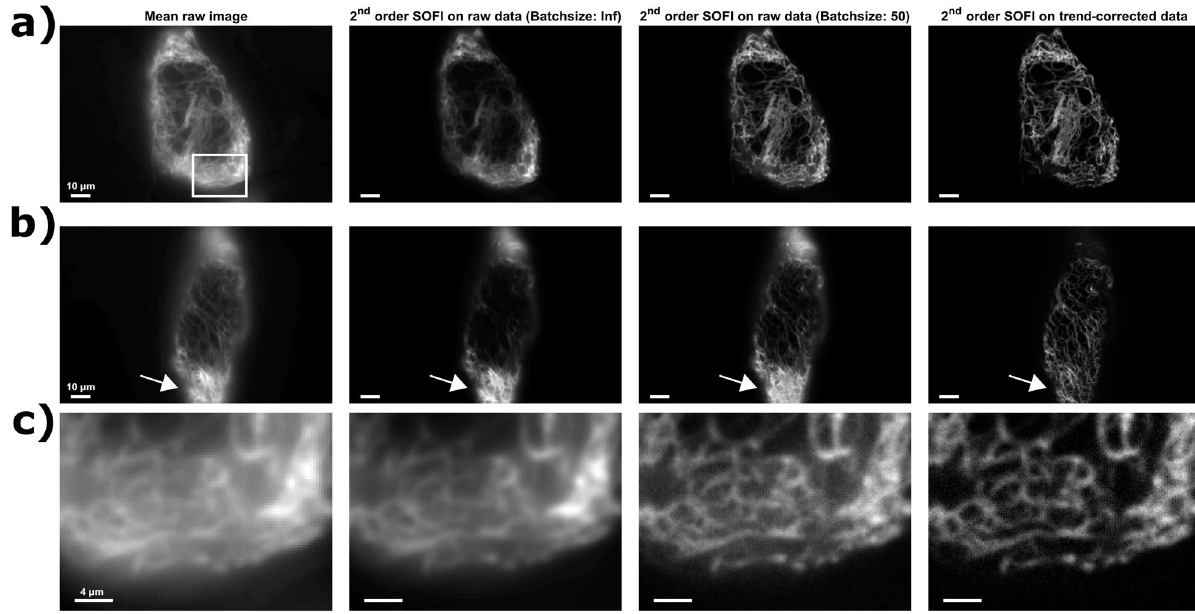
Figure 2. Second order SOFI results on two different datasets as shown in ( a ) and ( b ). The mean raw image is compared to the second order SOFI result on the entire raw data sequence, the raw data using batches of 50 frames and the trend-corrected data. A zoom of the box shown in the left panel of ( a ) is shown in ( c ) where the enhancements after performing the correction method are further highlighted. All results were obtained using Matlab R2018b (Mathworks,